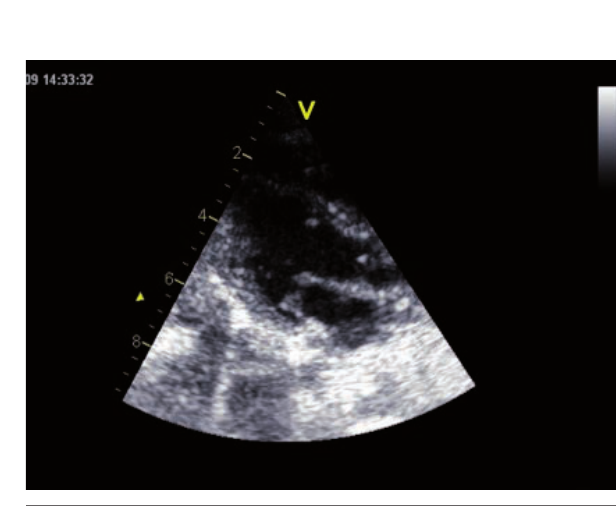
Figure 8. Adult mucopolysaccharidosis Figure 9. Increased thickness of the interventricular septum in a 8-month old (MPS) type III B patient without typical mucopolysaccharidosis type I patient. facial features of MPS.